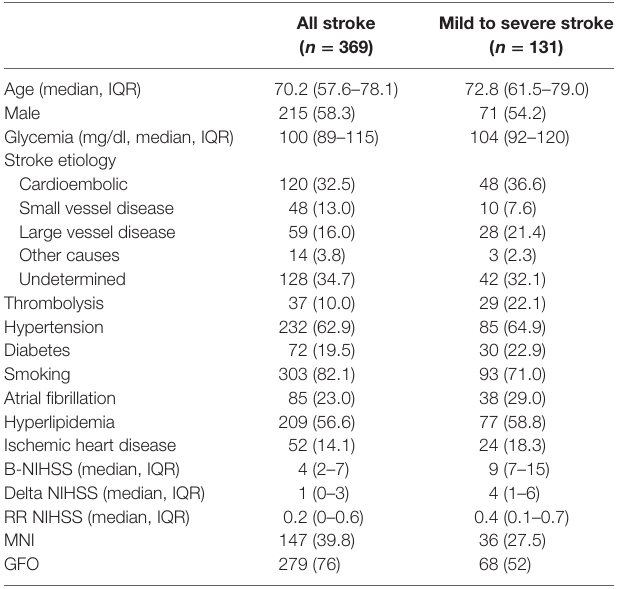
TaBle 1 | Baseline characteristics and outcome of in the overall population and